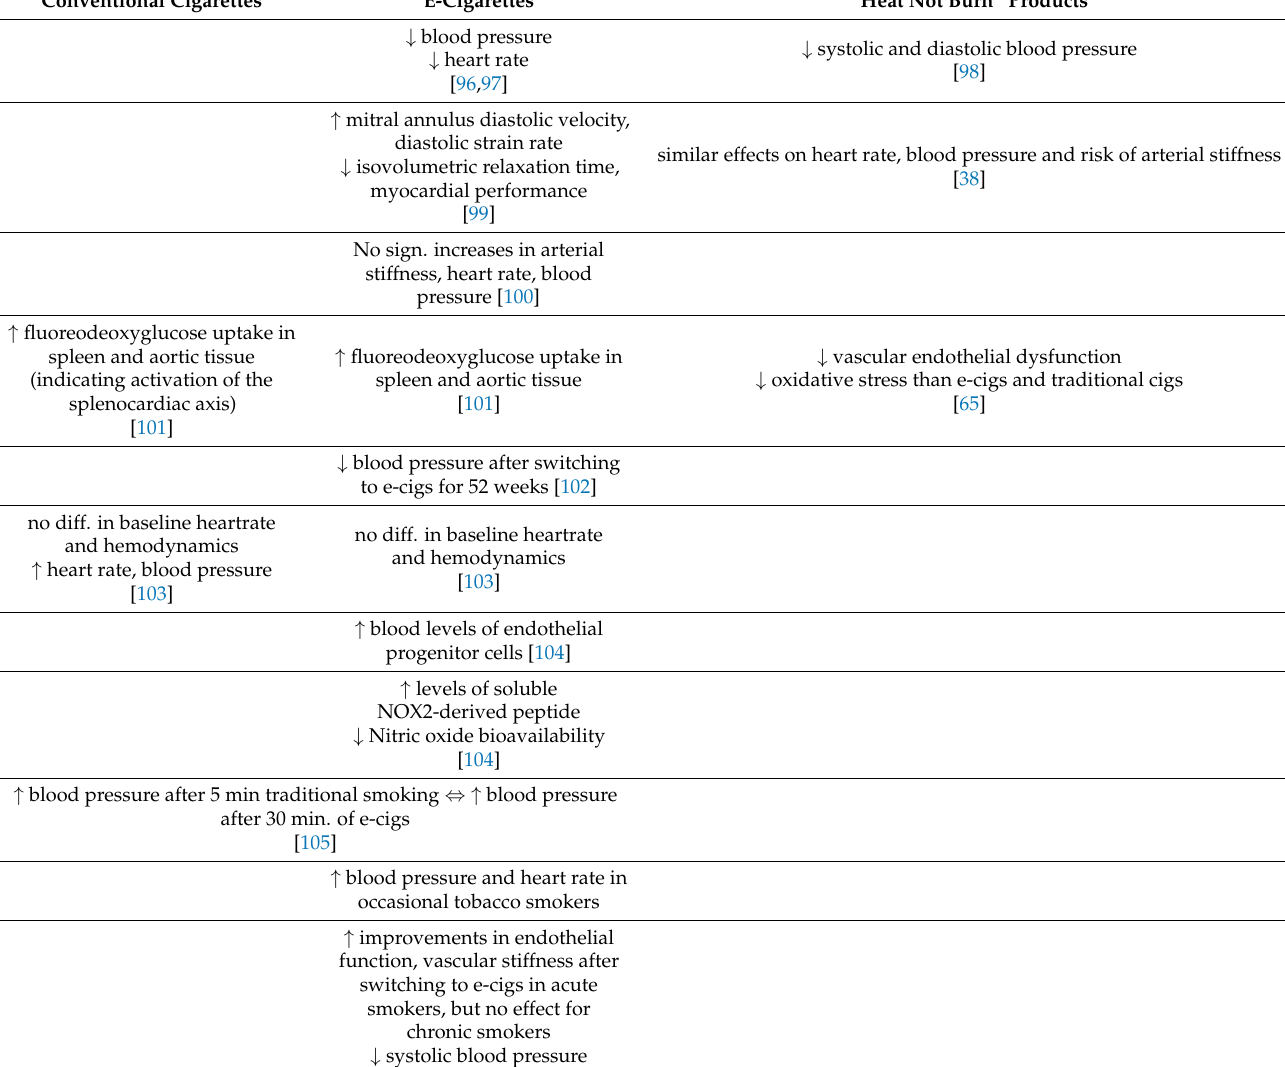
Table 1. Main differences in cardiac deleterious effects between the ENDS, HTPs and